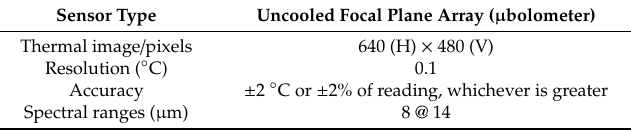
Figure 3. Experimental setup: relative positions of the sample, the stove and the thermographic camera, in transmission mode. Table 1. Specifications of the thermographic camera used.